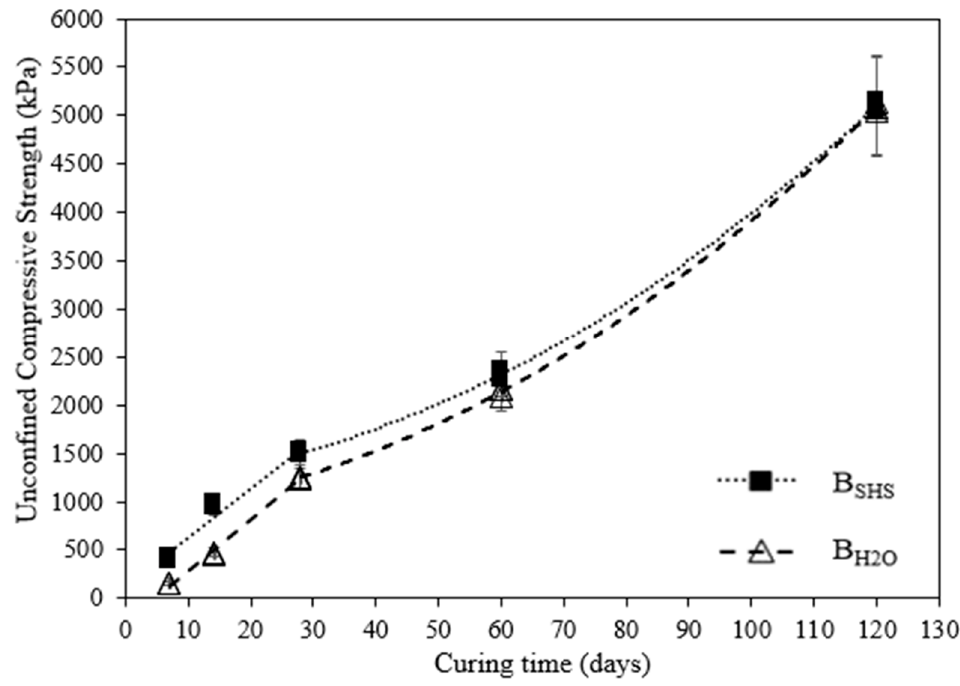
Figure 8. Variation in the UCS of the laboratory specimens with curing time .